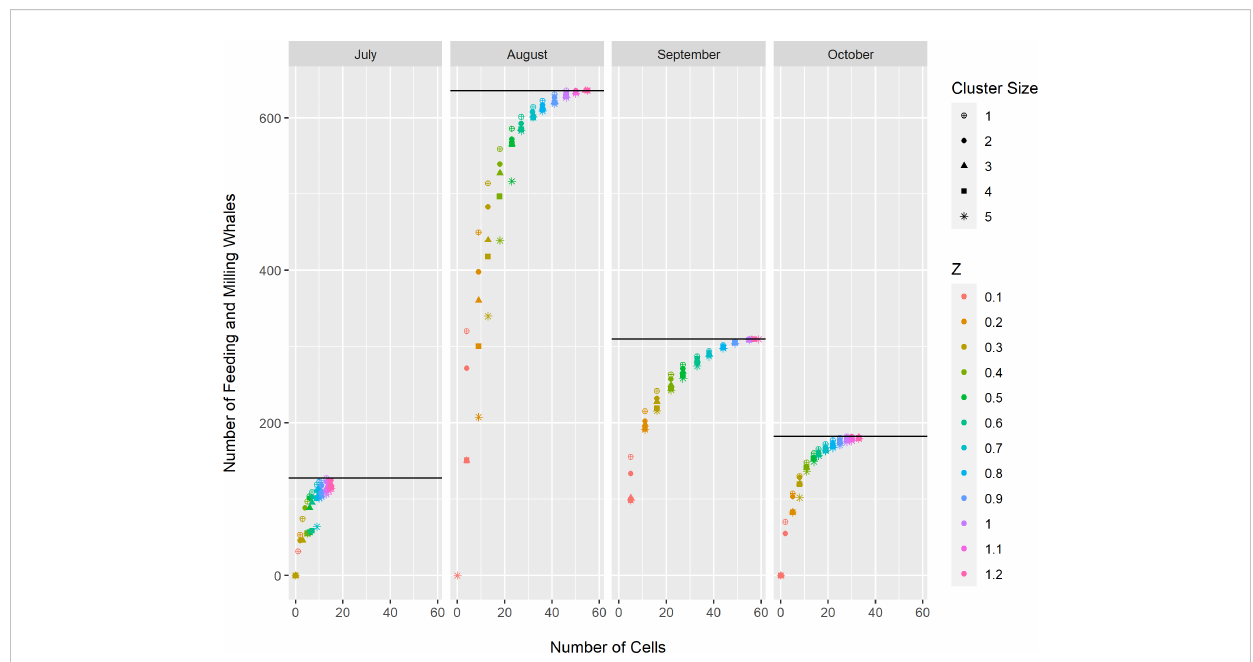
FIGURE 2 Estimated number offeeding/milling bowhead whales (Eqn. 1) enclosed by Biologically Important Areas for spatial optimization models constructed for each month (July-October), minimum contiguity threshold (cluster size 1-5), and maximum occupied area threshold (Z = 0.1, 0.2, 0.3, 0.4, 0.5, 0.6, 0.7, 0.8, 0.9,